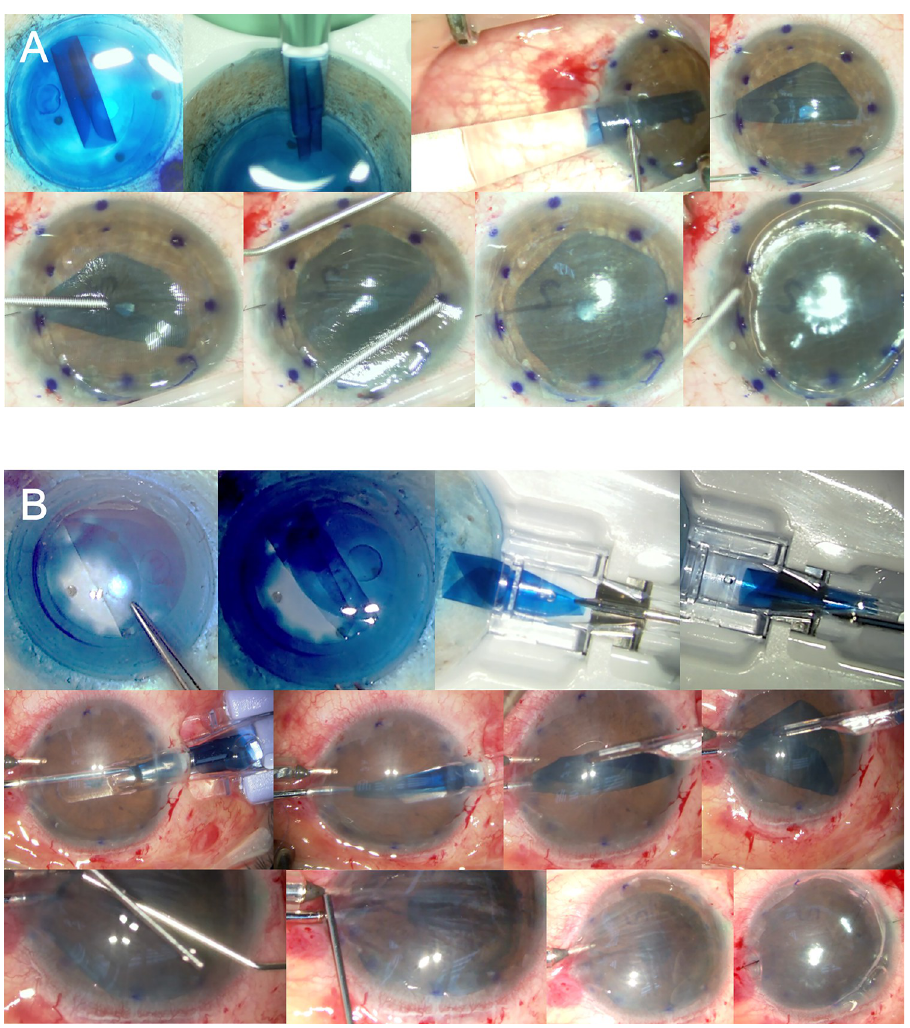
Fig 2. Representative photographs of surgical procedures in Descemet membrane endothelial keratoplasty (DMEK). Endothelium-out delivery with John’s tube (A) and endothelium-in technique using the DMEK EndoGlide